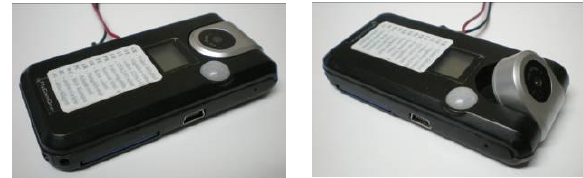
Figure 4. The modified FlyCamOne-2 pocket camera